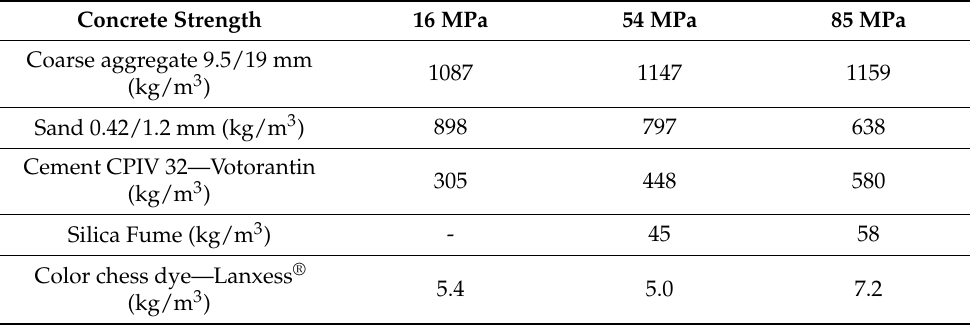
Table 1. Concrete mix design.